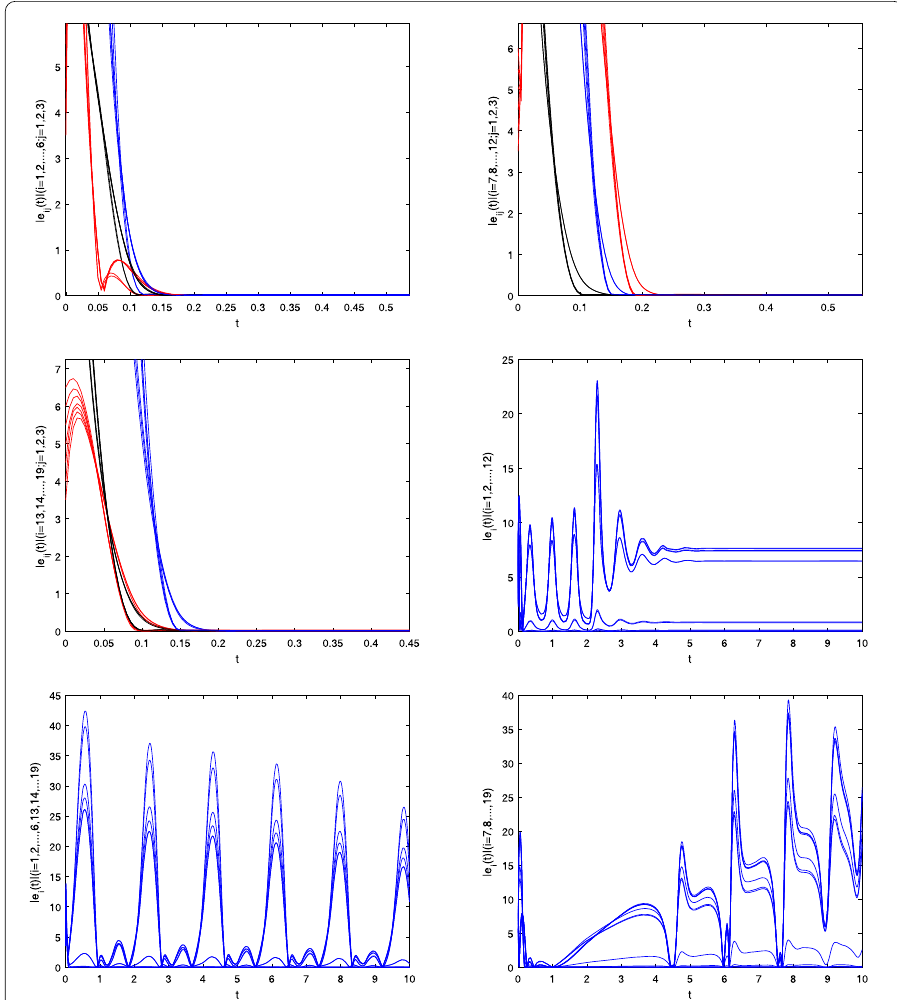
Figure 5 The synchronization errors in the same group and among the different groups